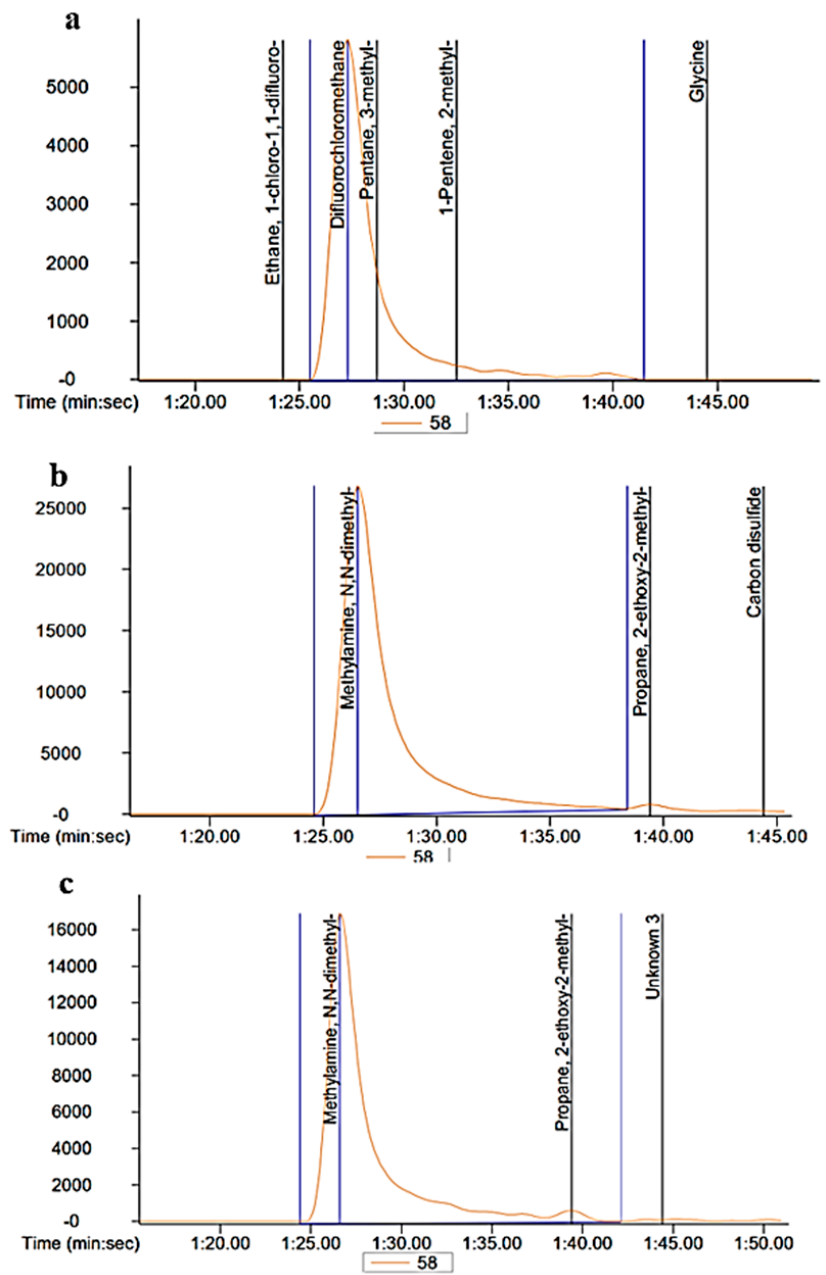
Figure 6. Effect of smoking on TMA content in CM fillets. The results were compared with ( a ) standard, ( b ) raw CM, and ( c ) hot smoked CM.